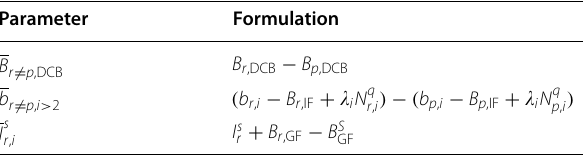
Table 3 The estimable formulation for the un-differenced and un-combined PPP–RTK sever model Parameter Formulation